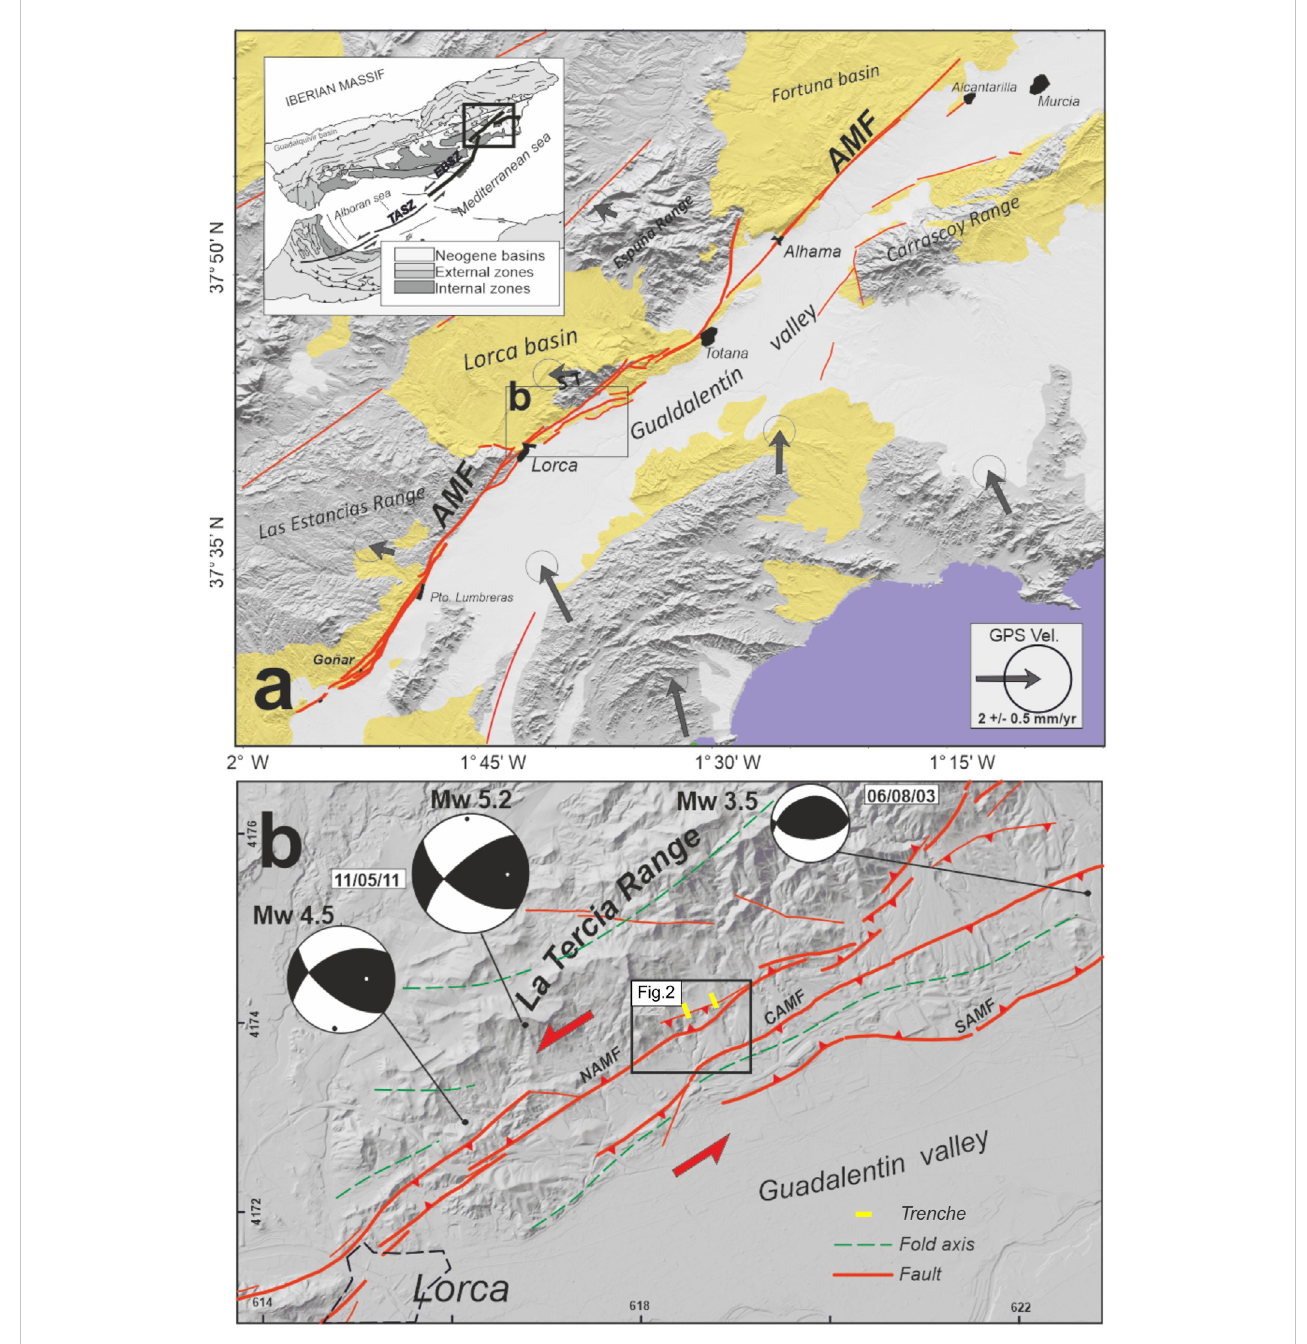
FIGURE 1 Location map of the study area in the eastern sector of the Trans-Alboran Shear Zone (TASZ). (A) Alhama de Murcia Fault trace (AMF). The fault limits the Neogenebasins(yellowzones)andthemountainrangesofLaTercia,SierraEspuñaandLasEstanciastothenorthwestandtheQuaternaryGuadalentínValley (white zones) to the southeast. GPS velocities from CuaTeNeo network in eastern Betics calculated by Echevarria et al., 2013 considering the Iberian massif fi xed. (B) Digital elevation model of the Lorca-Totana section of the AMF with the latest seismic series occurring in the area. NAMF, North Alhama de Murcia Fault; CAMF, Central Alhama de Murcia Fault; SAMF, South Alhama de Murcia Fault. The inset shows the Carraclaca study area in Figure